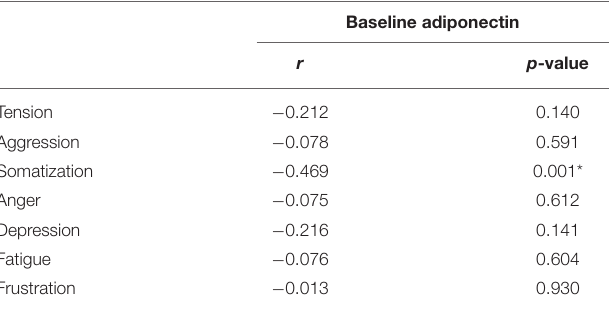
TABLE 4 | Pearson’s correlation coefficients between baseline adiponectin levels and 12-week changes in SRI subscales in patients with